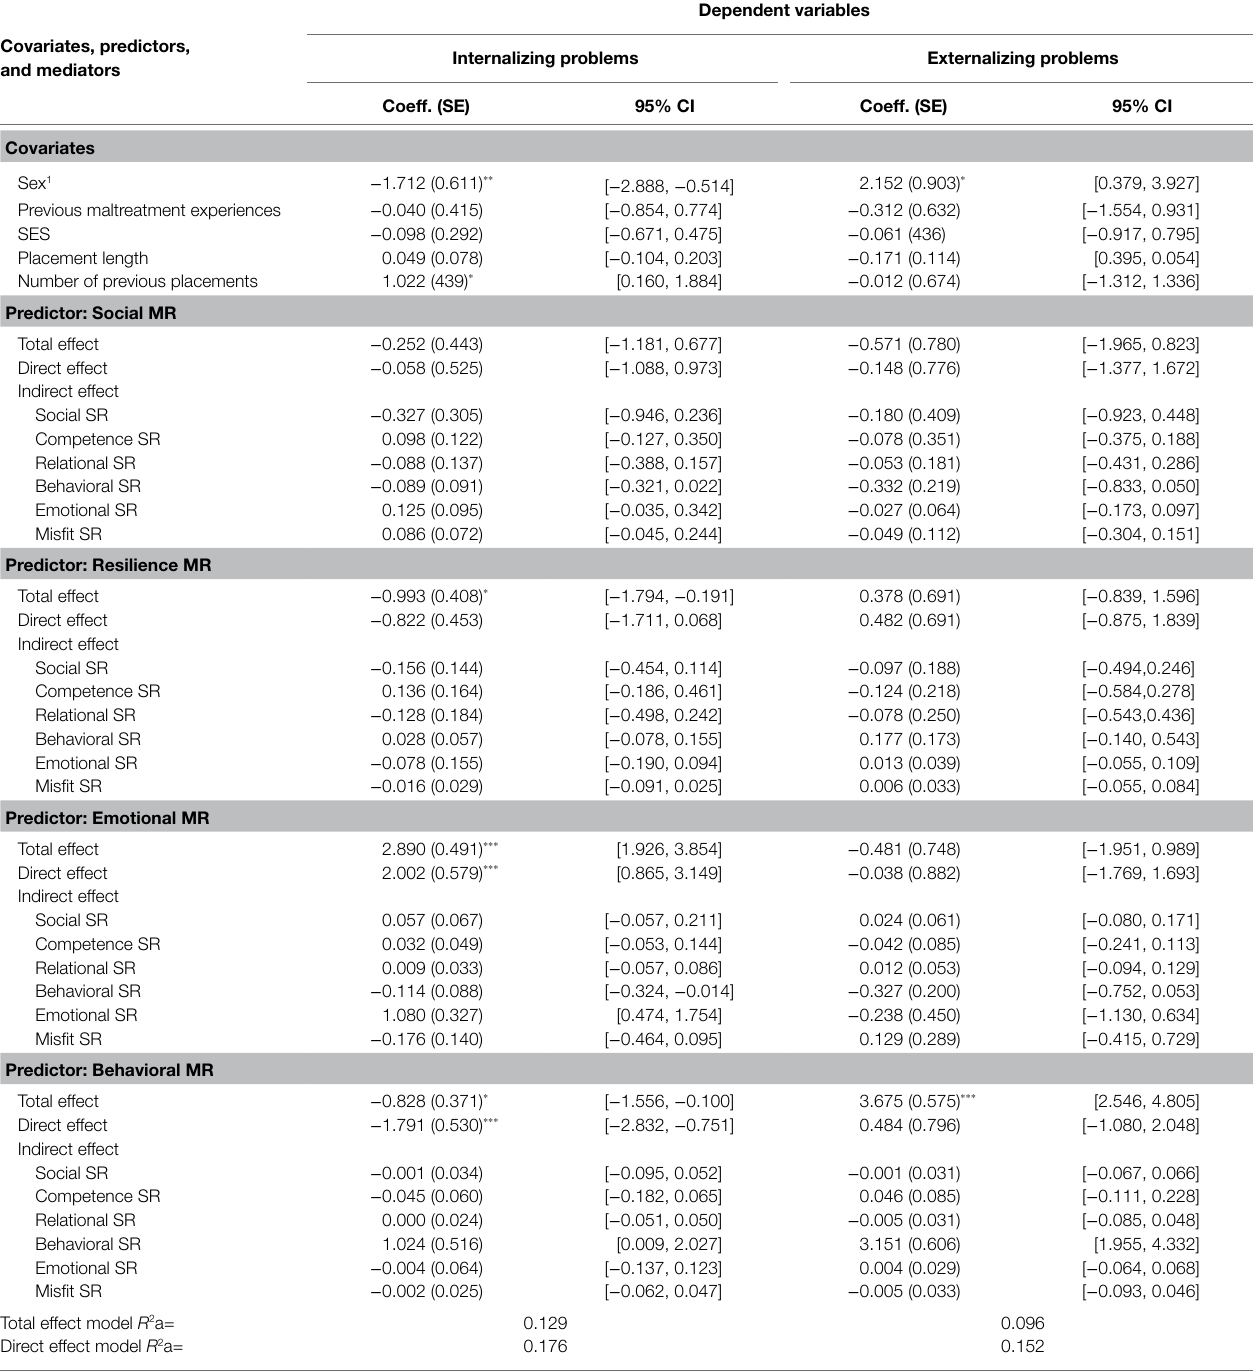
TABLE 3 | Multiple mediation